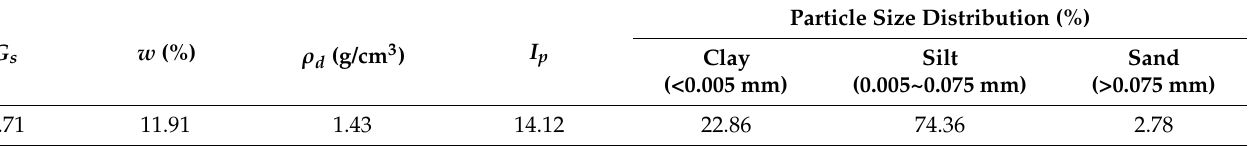
Table 1. Physical properties of the test sample.